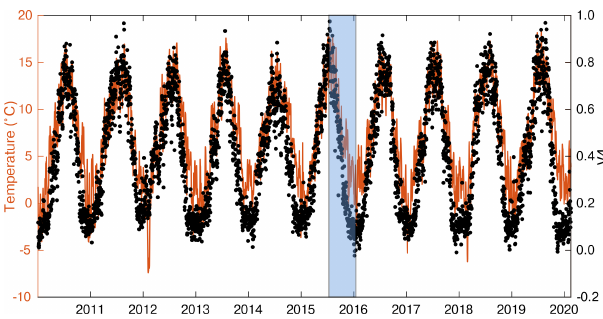
Figure 9. Comparison between the daily mean temperature of the study area (orange) and the temporal evolution of IC4 (black dots). The shaded area represents the time interval associated with the maximum displacements shown in Fig.